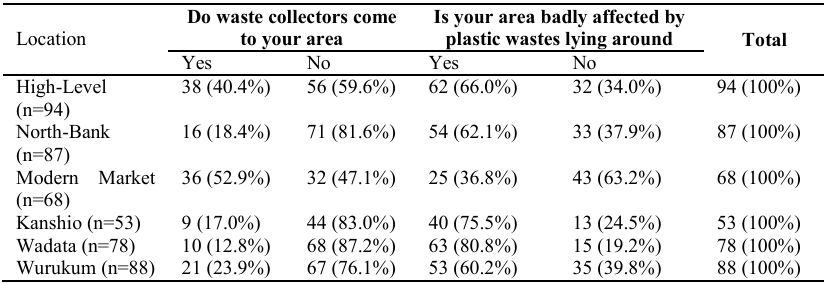
Table 6: Presence of waste collectors in the 6 sub-locations of Location